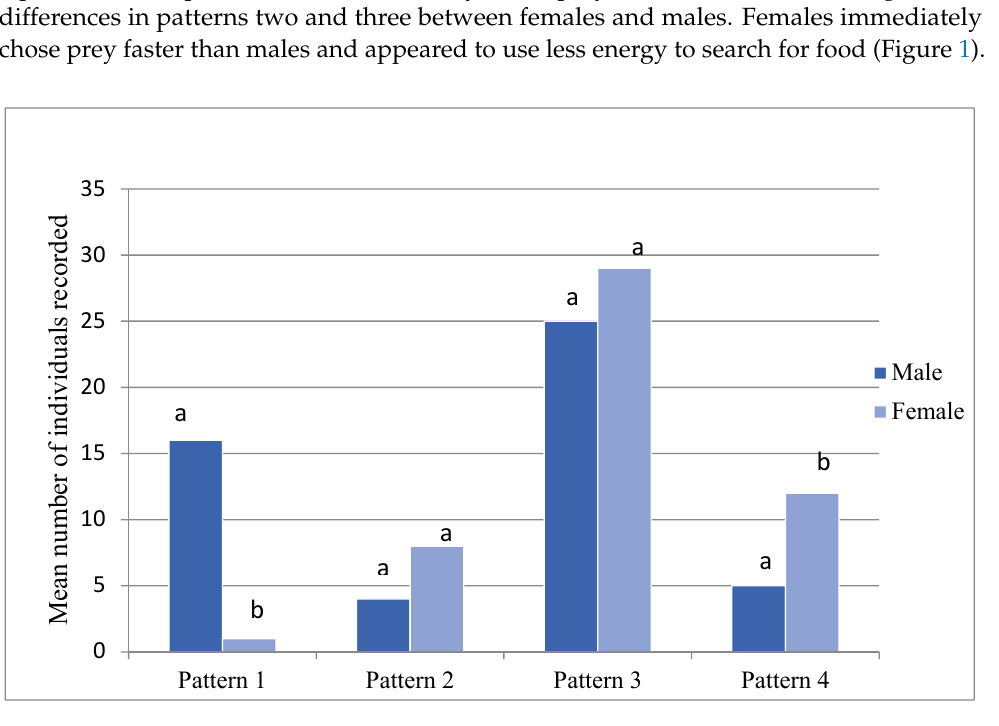
Figure 1. Patterns of movements exhibited by male and female T. montezumae in the presence of the prey P. howertoni . Pattern types: (1) contacted and stayed with first prey encountered; (2) moved from prey to prey; (3) walked around Petri dish without prey contact; and (4) went directly to prey. Different letters above bars in each pattern indicate significant differences in the treatments ( p < 0.05, Tukey’s test)